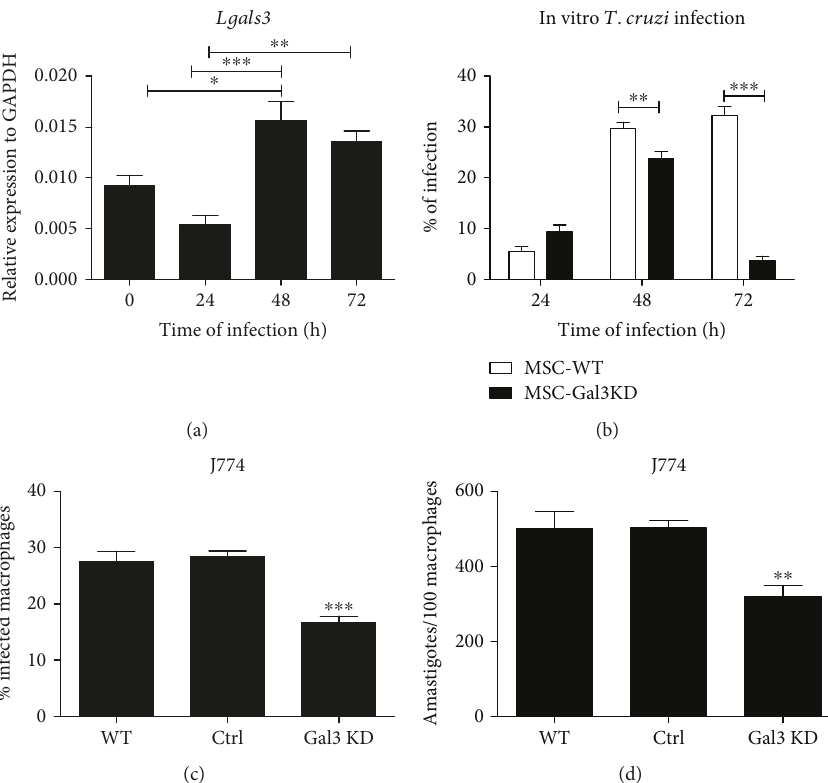
Figure 7: Gal-3 knockdown impairs T. cruzi infectivity in vitro. (a) Gene expression of Gal-3 is increased 48h and 72 h after infection of MSC-WT with T. cruzi . (b) Percentage of T. cruzi infection in MSC-WT and MSC-Gal3KD lines during the fi rst 72h. (c) Percentage of infection and (d) number of parasites per cell in J774 macrophages nontransduced (WT) or transduced with control vector (Ctrl) or Gal-3 shRNA (Gal3 KD). ∗ P < 0 05 ; ∗∗ P < 0 01 ; ∗∗∗ P < 0 001